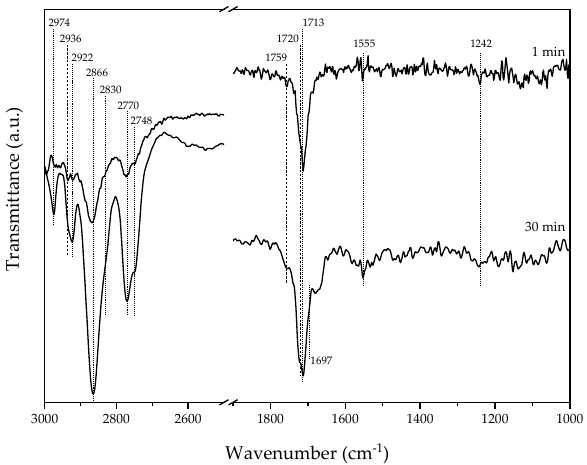
Figure 2. Di ff use-reflectance infrared Fourier transform spectroscopy (DRIFTS) spectra recorded after 1 and 30 min of acetaldehyde adsorption on Ag / TiO 2 / SiO 2 at 298 K and atmospheric pressure. Table 1. Adsorbed acetaldehyde: observed bands and their assignments.